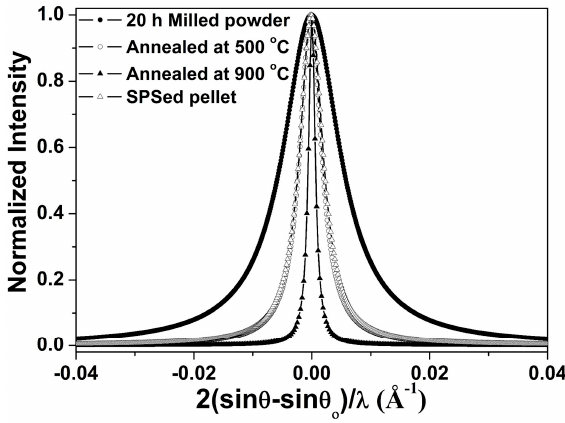
Figure 6. The broadening of (110) peak of Fe–10Cr–3Al alloy; 20 h milled powder, annealed powder at 500 and 900 °C and pellet sintered at 900 °C. Here, θ and θ o are diffraction and exact Bragg angles, respectively.